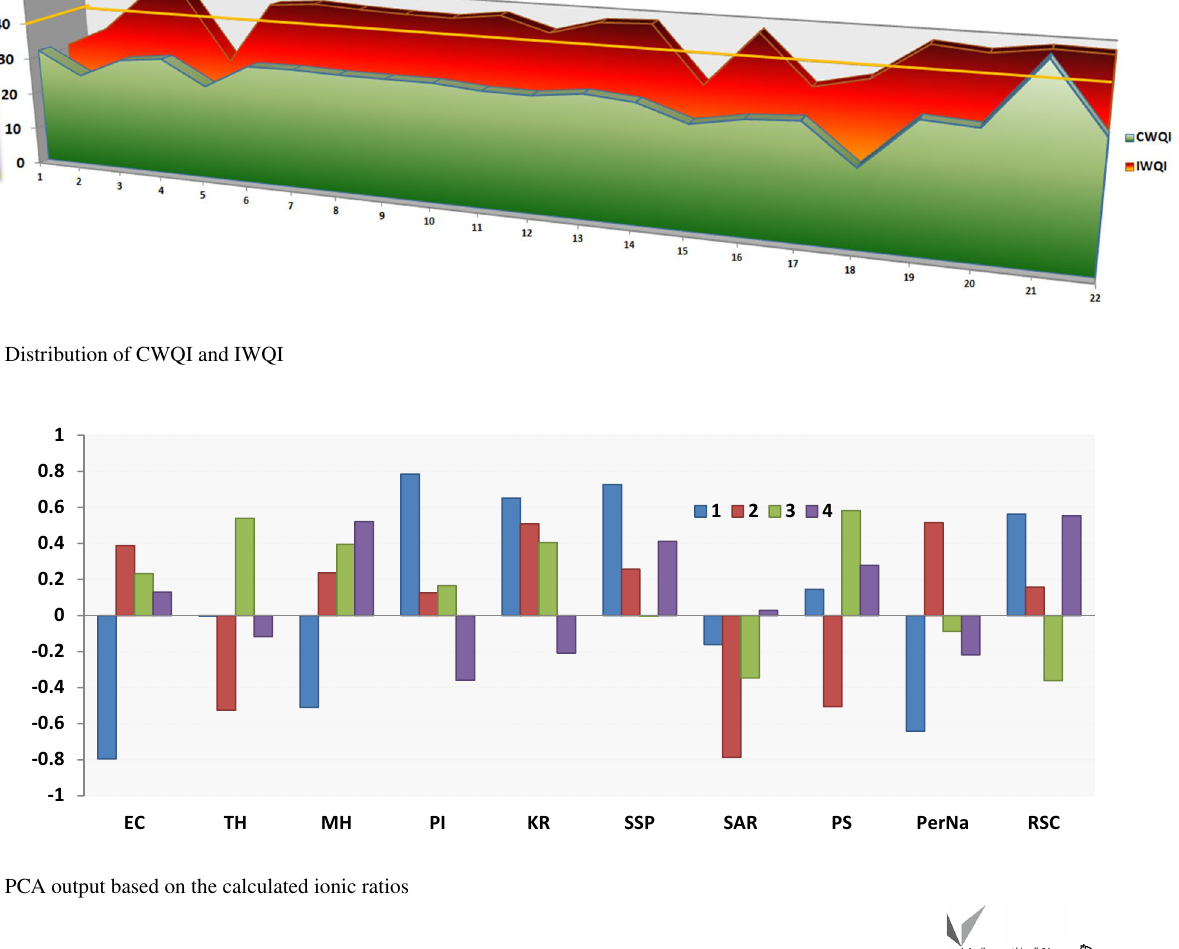
Fig. 8 PCA output based on the calculated ionic